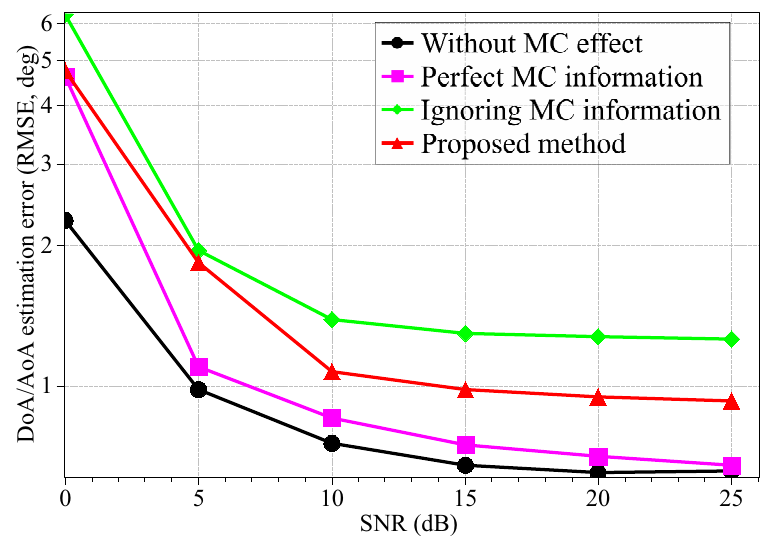
Figure 3. The DoD/DoA estimation performance with different SNRs (the MC effect is − 10 dB between adjacent antennas).